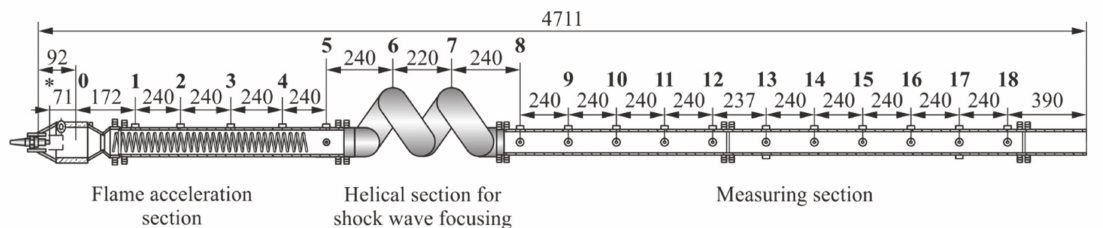
Figure 1. Schematic ( a ) and photo ( b ) of the test bench with the standard pulsed detonation tube.